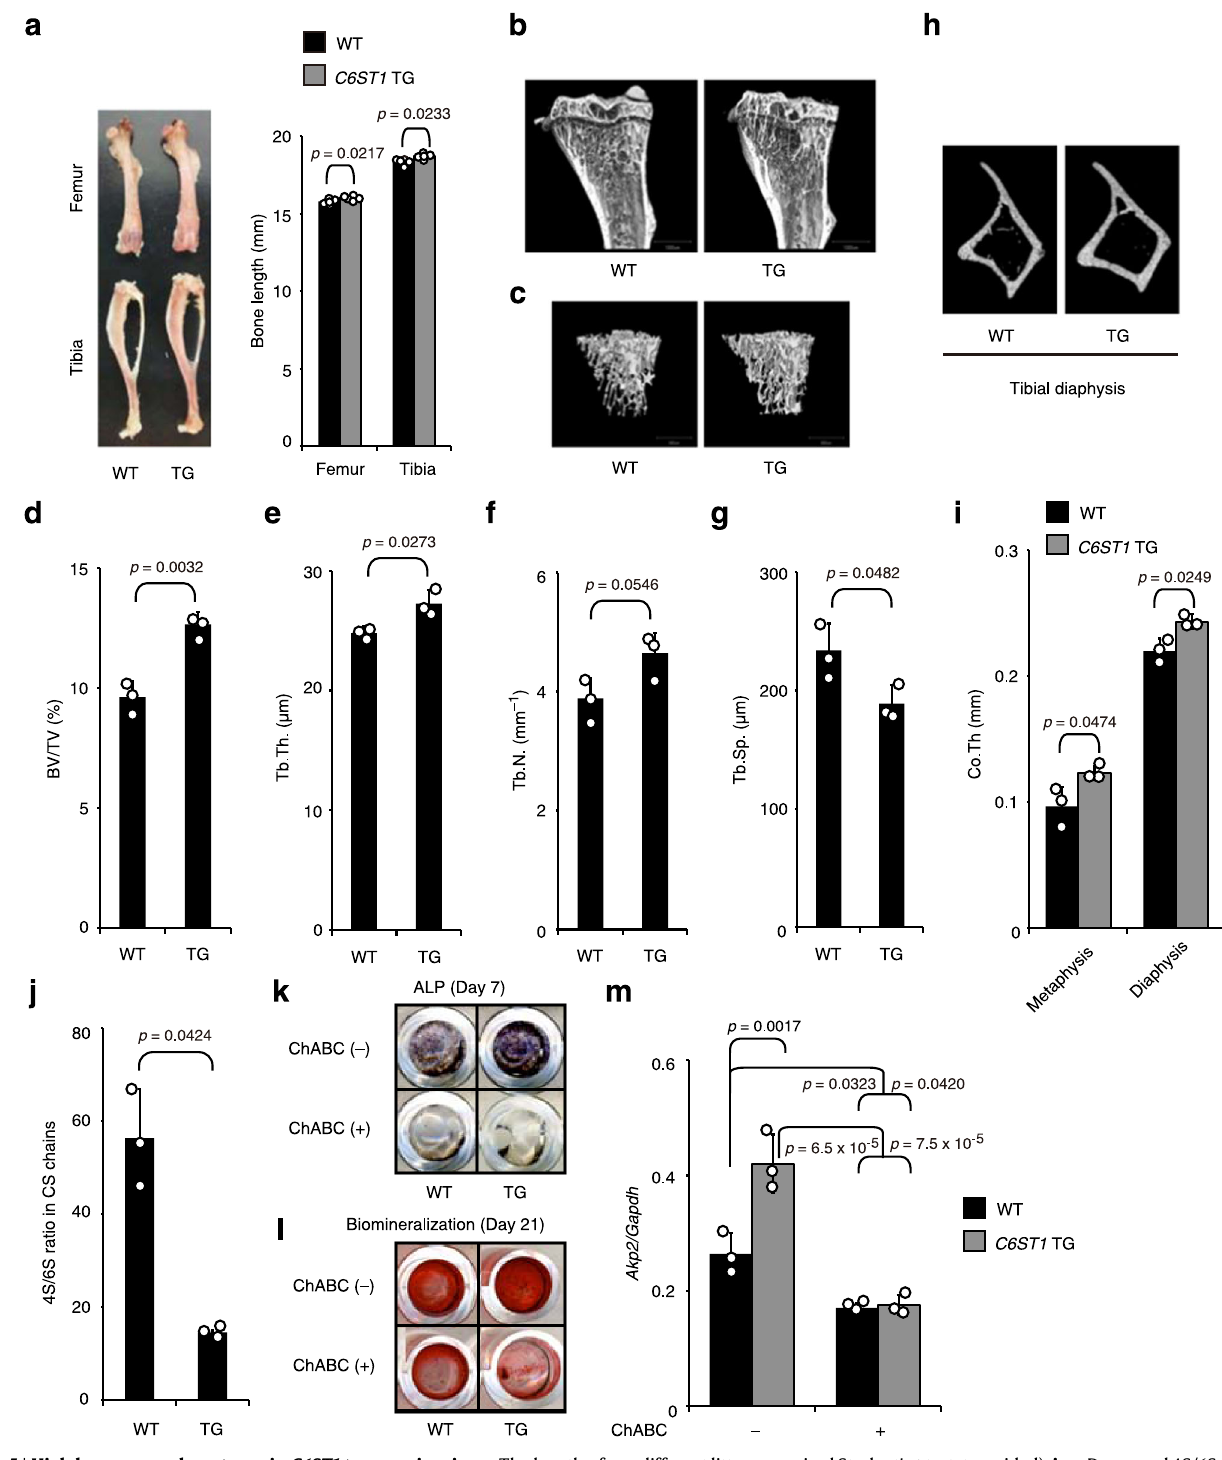
differentlitters,unpairedStudent ’ s t -test,two-sided). j – m Decreased4S/6Sratioof CS chains promotesosteoblastogenesis. j The 4S/6S ratio ofCS chains from WT or C6ST1 TGBMSCs( n =3culturesfrom3independentmicelitters,foreachgenotype, unpairedStudent ’ s t -test,two-sided). k – m OsteoblasticpotentialofBMSCsisolated from WT or C6ST1 TG male mice. BMSCs were maintained in a differentiation medium(DM)for21daysintheabsence( − )orpresence(+)ofChABC.ALPstaining ( k ) and Alizarin red staining ( l ) were performed on 7-day and 21-day cultures of BMSCs,respectively.Expressionof Akp2 mRNAin7-dayculturesofBMSCs( m , n =3 cultures from 3 independent mice litters, for each genotype, Tukey – Kramer mul- tiple comparison method). Data in a , d – g , i , j , and m are represented as the mean±s.d. Source data are provided as a Source Data fi le.